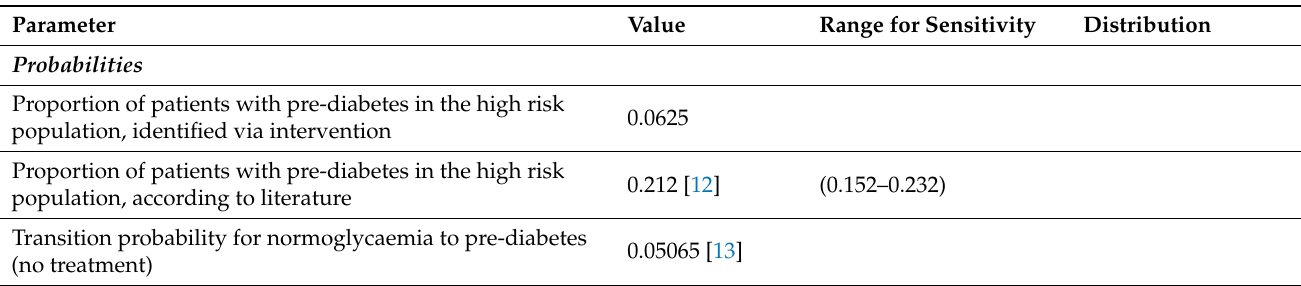
Table 1. Model inputs for the long-term cost-effectiveness